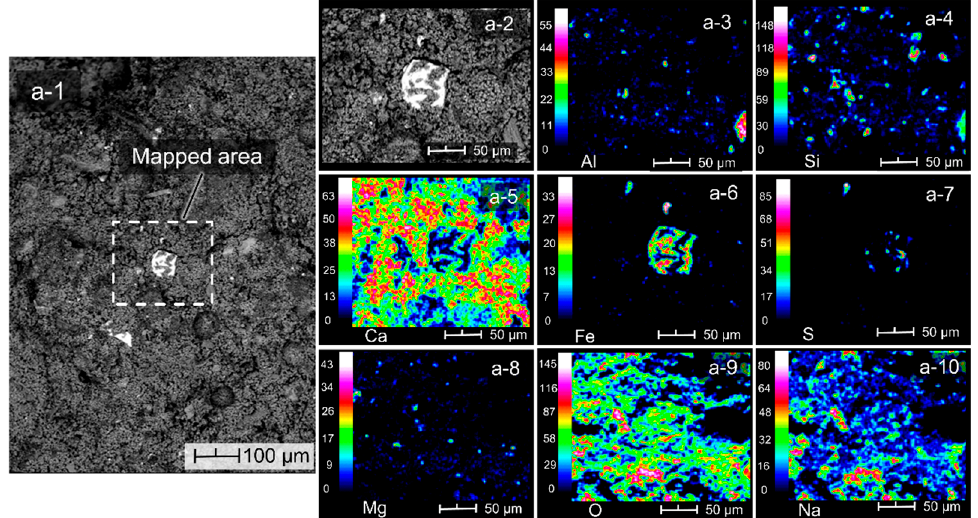
Figure 8. ( a-1 ) Photomicrograph of GPF and ( a-2 ) mapped area with corresponding elemental maps of Al ( a-3 ), Si ( a-4 ), Ca ( a-5 ), Fe ( a-6 ), S ( a-7 ), Mg ( a-8 ), O ( a-9 ) and Na ( a-10 ).